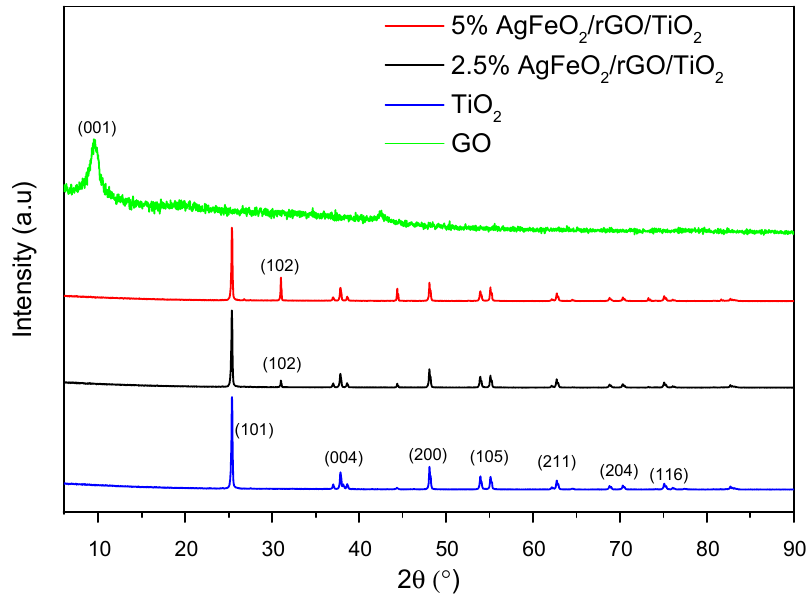
Figure 1. XRD pattern of Commercial Titanium dioxide (TiO 2 ), graphene oxide (GO), Ternary composite photocatalyst (2.5% AgFeO 2 /rGO/TiO 2 ) and 5% AgFeO 2 /rGO/TiO 2 .